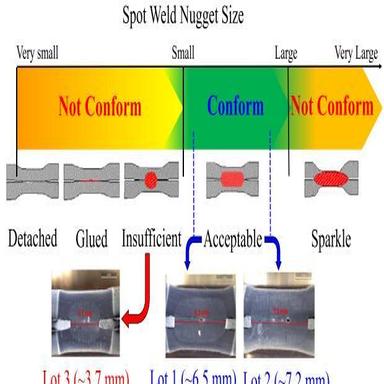
Spot welds quality according to the nugget size and the three considered lots.